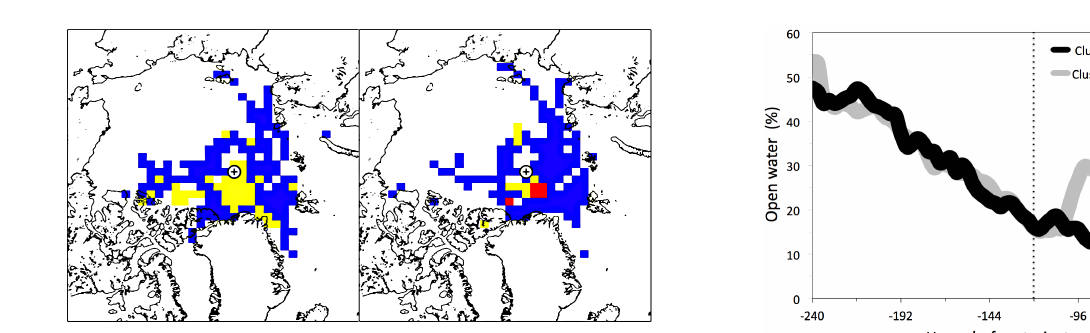
Figure 15. Median open water percentages along the trajectories of clusters 1–3 in pack ice low experiment (see Fig. 9) and those of clusters 1, 2, 3, and 6 in the open water experiment (see Fig.